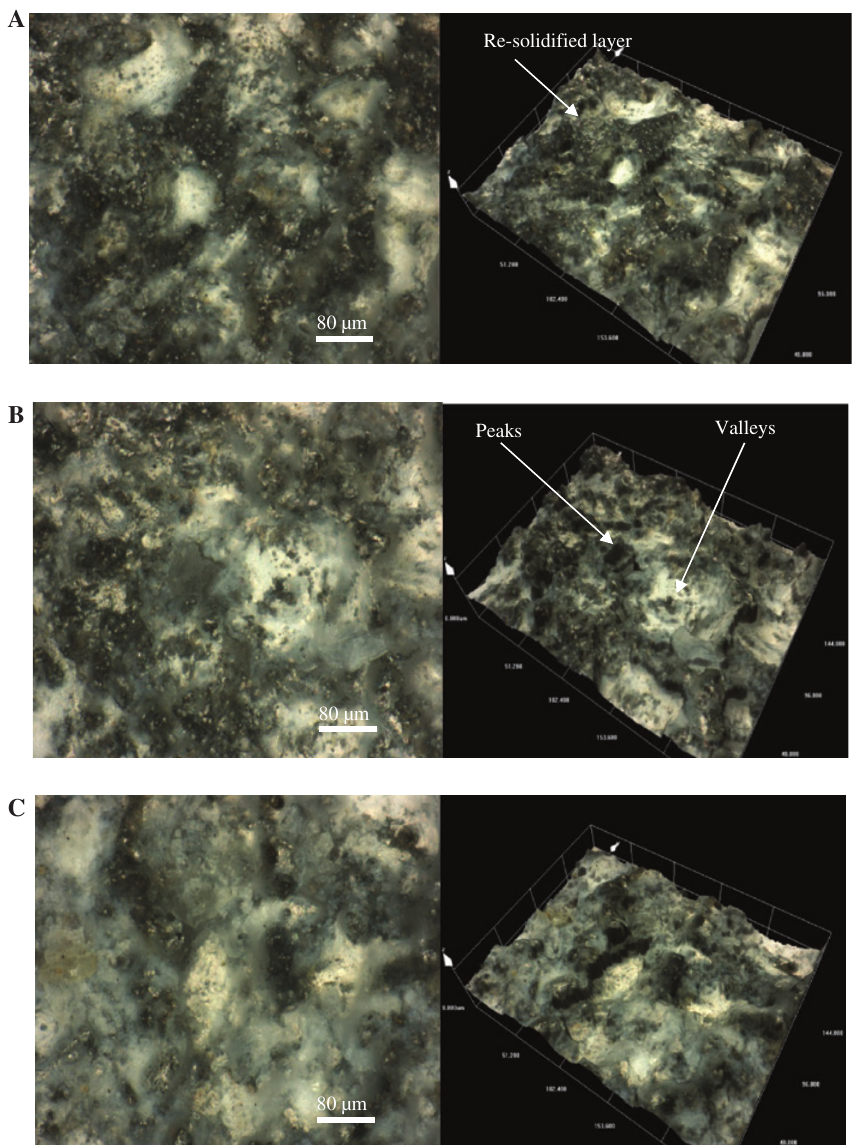
Figure 9: 2D and 3D surface topography of the machined surfaces at (A) 200 rpm, (B) 400 rpm, and (C) 600 rpm.